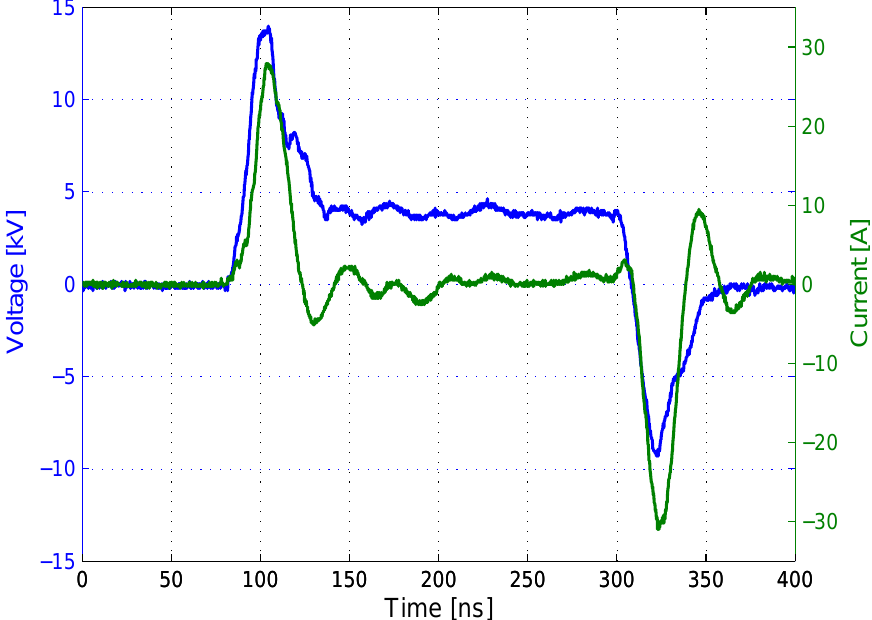
Figure 4. Sample current and voltage waveforms for the ns-pulse (NS-P) power